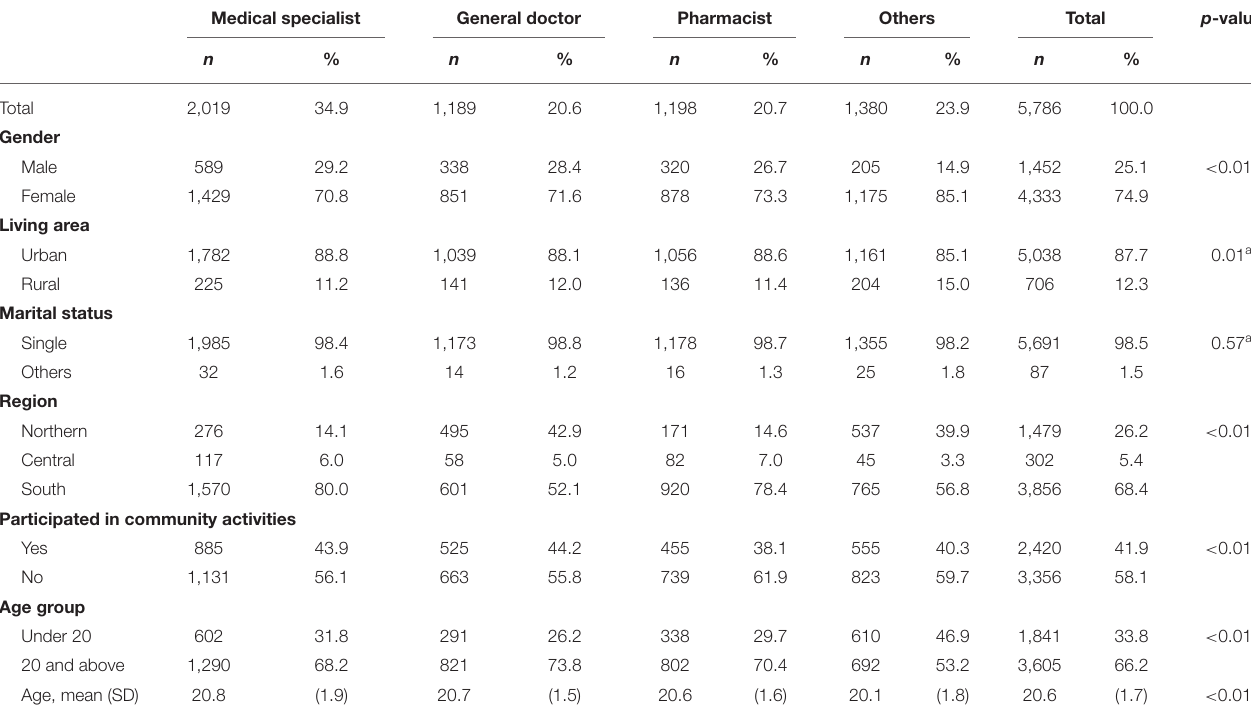
TABLE 1 | Socioeconomic characteristics of medical students.